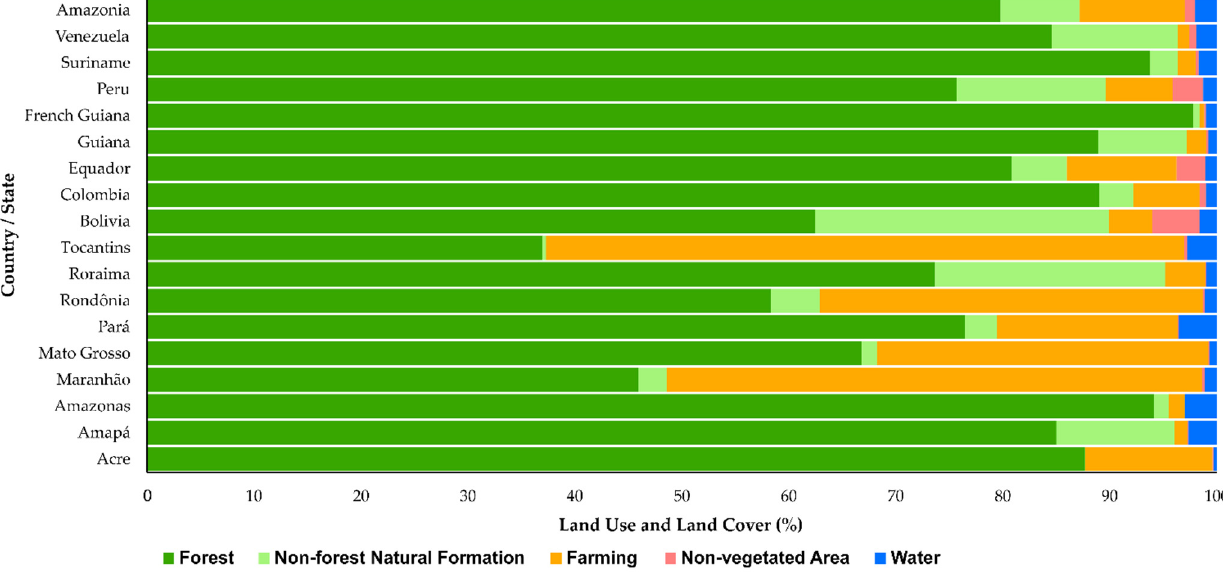
Figure 7. Quantification of Land Use and Land Cover defined by the MapBiomas Amazonia dataset Collection 2.0 in Amazonia and in its 17 countries/states for the year